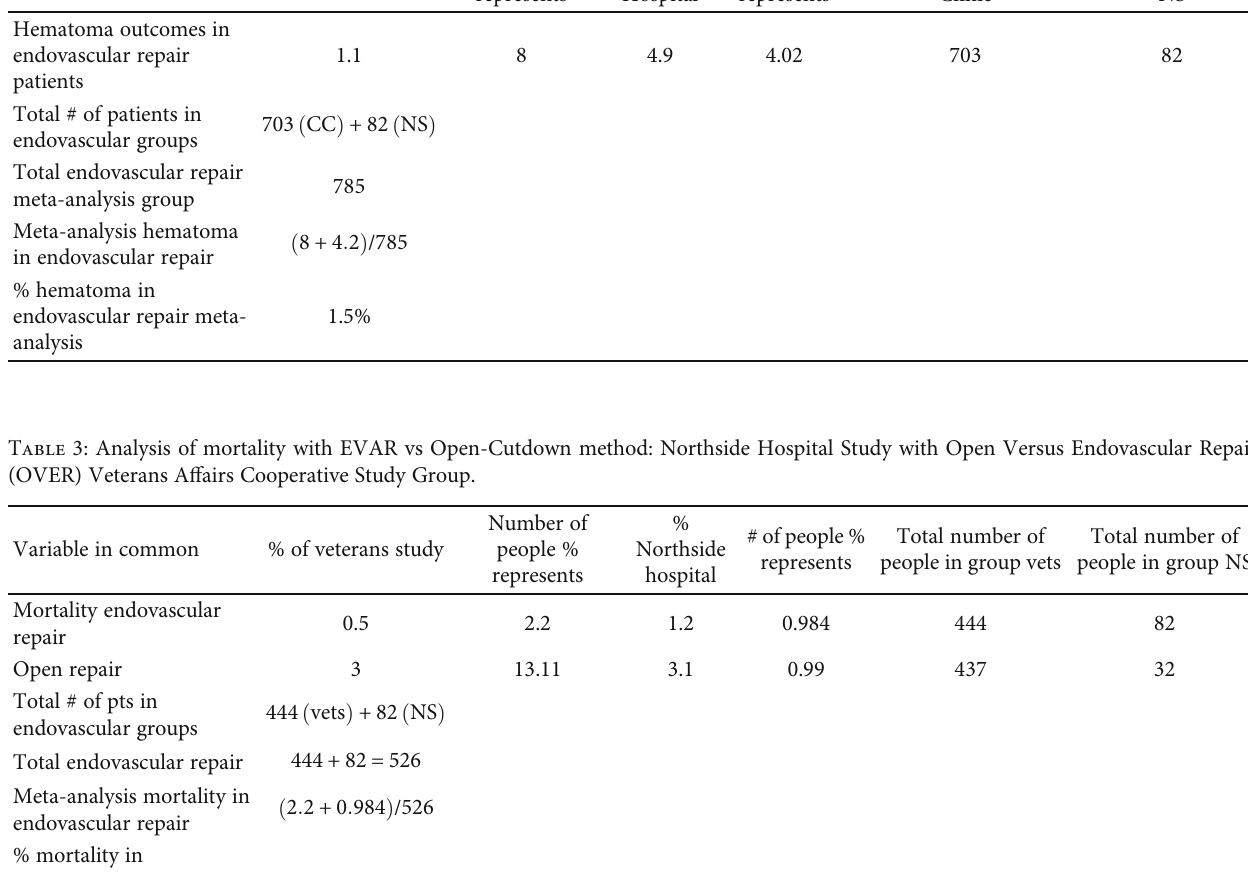
Table 2: Analysis of hematoma associated with EVAR. Northside Hospital Study with Cleveland Clinic Study (Sampram et al.). Variable in common